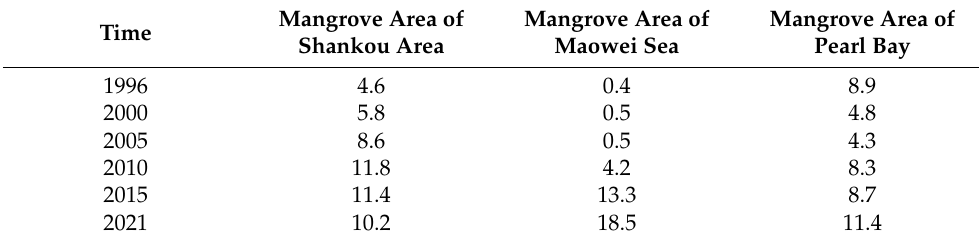
Table 4. Mangrove area in key study